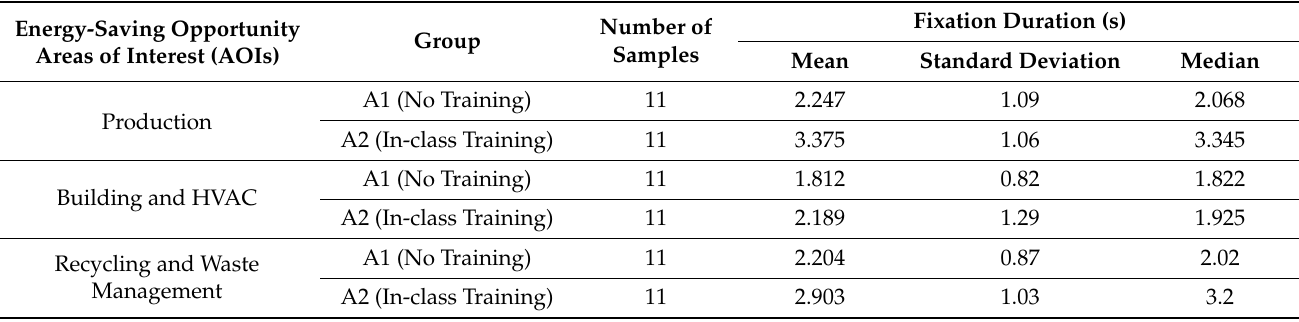
Table 3. Participants’ performance before and after in-class